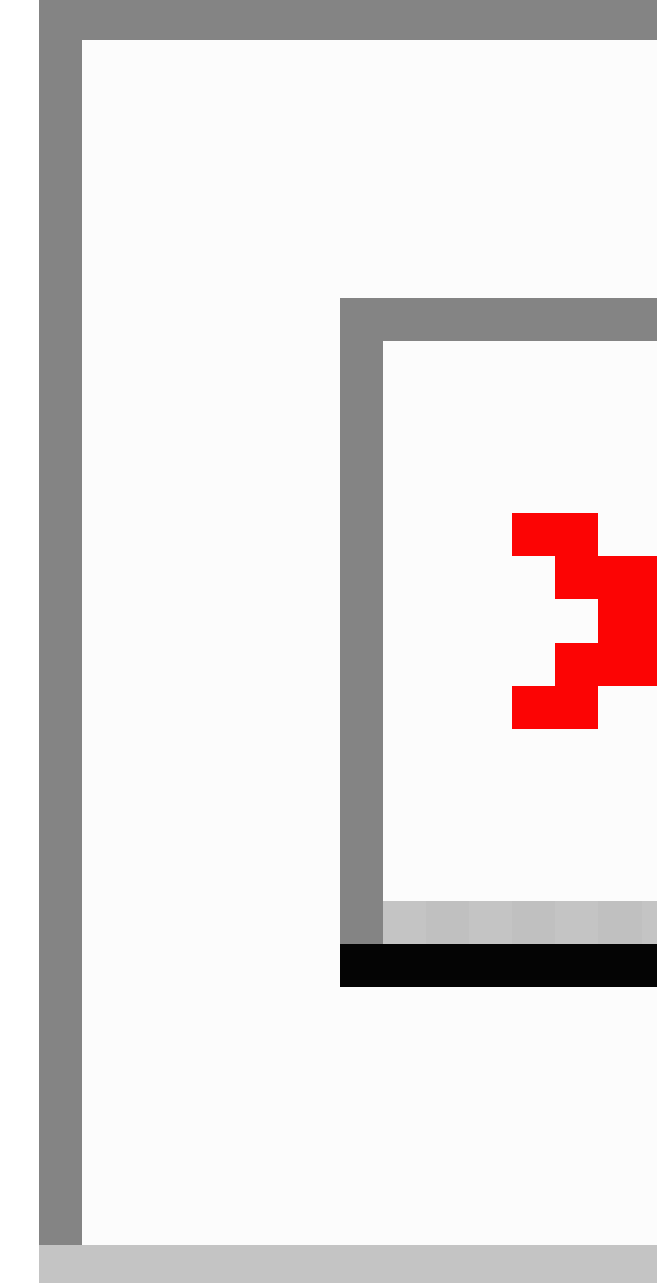
Figure 2. The 20 pictograms and their comprehensibility